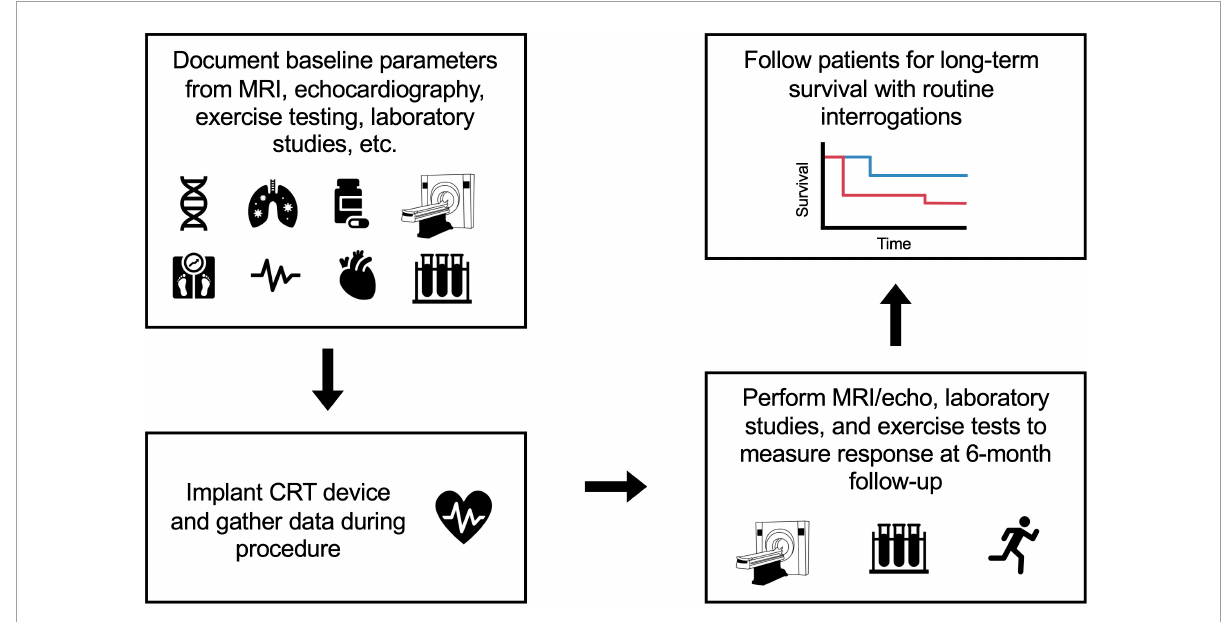
FIGURE1 Flow diagram of the study design. Patients were enrolled over approximately a 10-year period from 2011 to 2021. Before CRT device implantation, the baseline parameters of the patients were recorded based on findings from MRI, echocardiography, electrocardiograms, exercise testing, and laboratory studies. Additional parameters (such as QLV which indicates late activation of LV pacing cite) were gathered during the CRT procedure. Six months after CRT, patients received follow-up MRI/echocardiograms, laboratory studies, and exercise testing to calculate response measures. Finally, patients were followed for long-term survival with routine